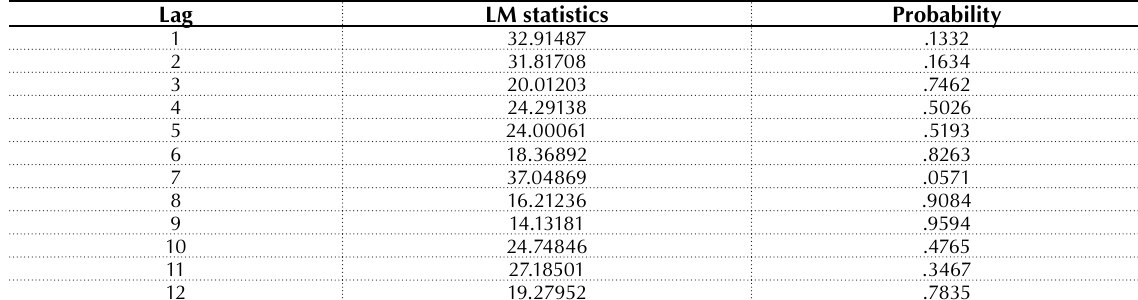
Table 4. LM test